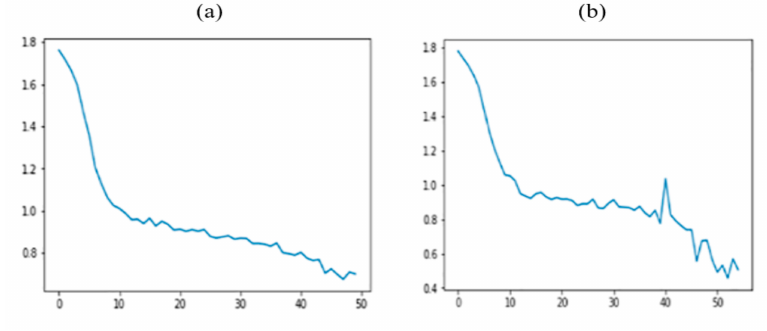
Figure 3. Data loss at ( a ) 50,000 and ( b ) 55,000